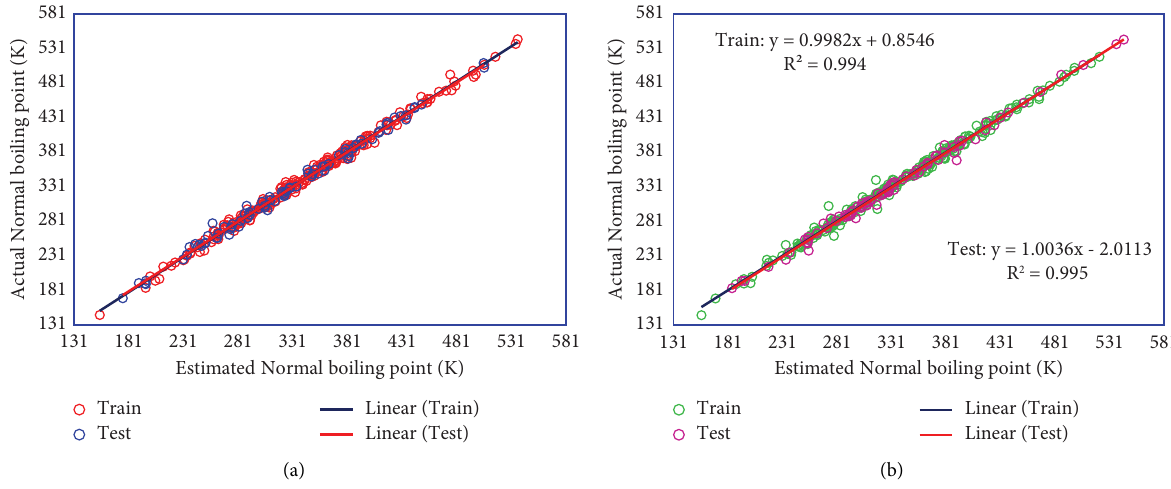
Figure 4: Cross plot of experimental and estimated normal boiling point. (a) EDT boosted and (b) ELM.